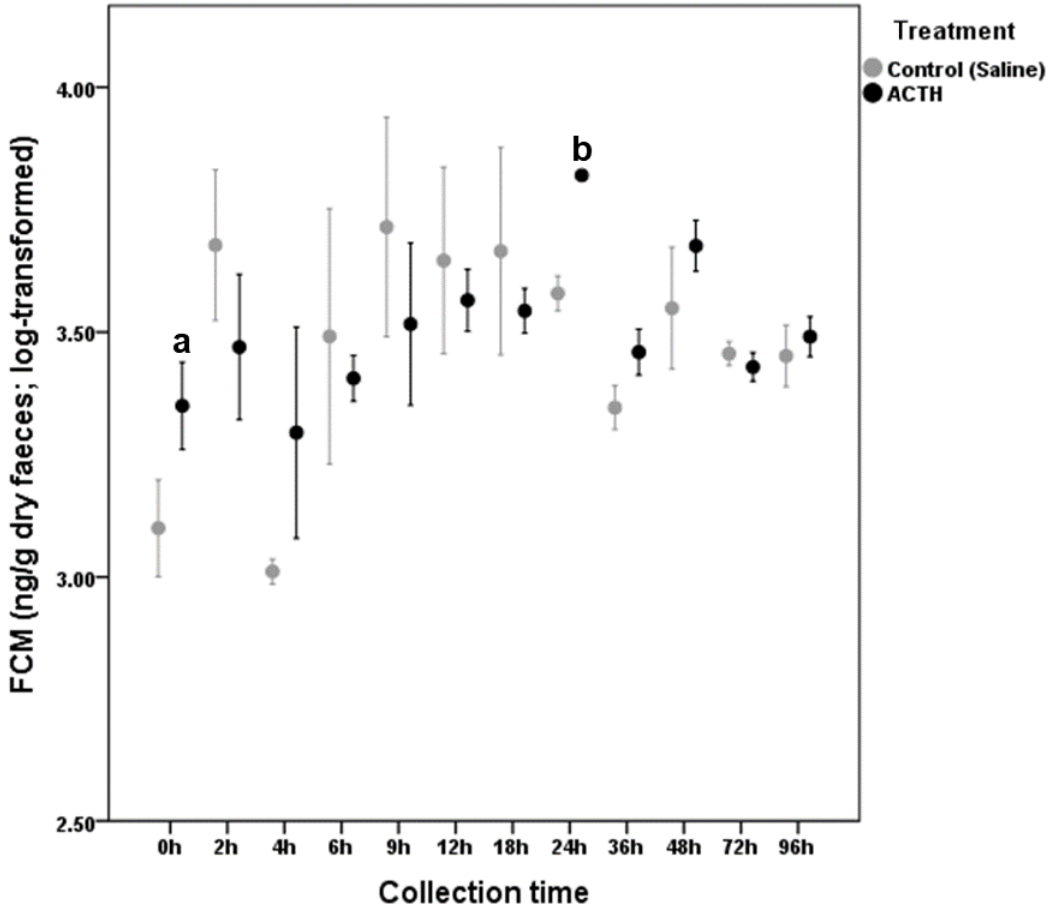
Figure 3. Fecal Corticosterone Metabolite variation (mean ± SE) in G. pyramidum (only males) after ACTH (adrenocorti- cotropic hormone) ( n = 3) or saline solution ( n = 3) injection. Significant differences between basal (right before the injection) and peak FCM (fecal corticosterone metabolites) values are indicated with different small letters.